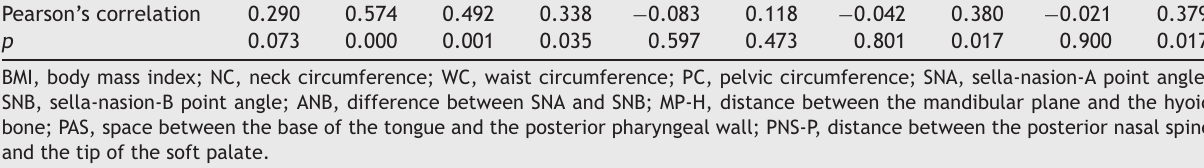
Table 6 Correlation in the age range ≥ 60 years of anthropometric and cephalometric measures with AHI ( n = 26). BMI NC WC PC SNA SNB ANB MP-H PAS PNS-P Pearson’s correlation 0.119 0.373 0.167 0.026 0.098 0.056 0.037 0.091 − 0.352 0.363 p 0.561 0.060 0.414 0.900 0.635 0.787 0.859 0.660 0.077 0.068 BMI, body mass index; NC, neck circumference; WC, waist circumference; PC, pelvic circumference; SNA, sella-nasion-A point angle; SNB, sella-nasion-B point angle; ANB, difference between SNA and SNB; MP-H, distance between the mandibular plane and the hyoid bone; PAS, space between the base of the tongue and the posterior pharyngeal wall; PNS-P, distance between the posterior nasal spine and the tip of the soft